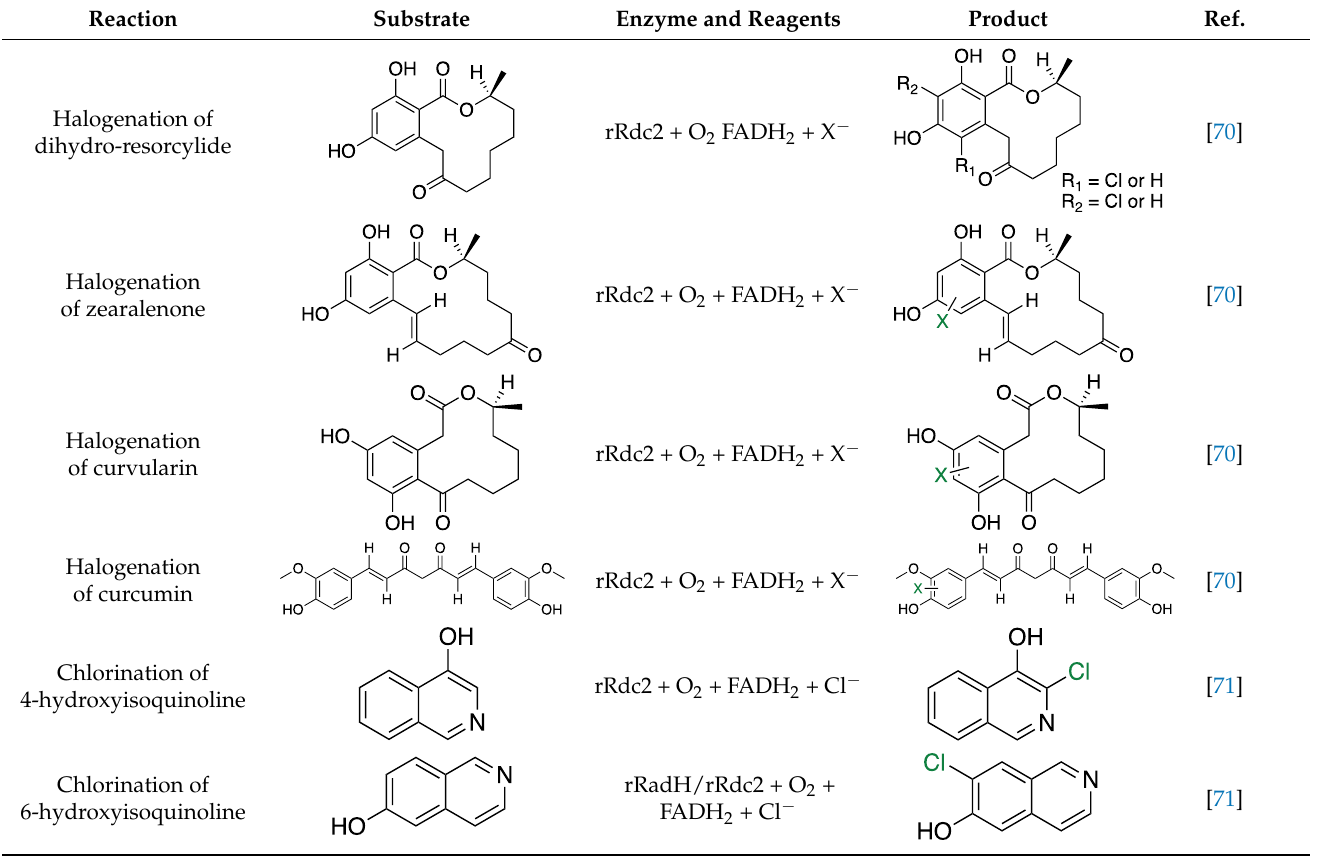
Table 3. Enzymatic halogenation catalyzed by some fungal flavin-dependent halogenases (r: recom- binant protein).